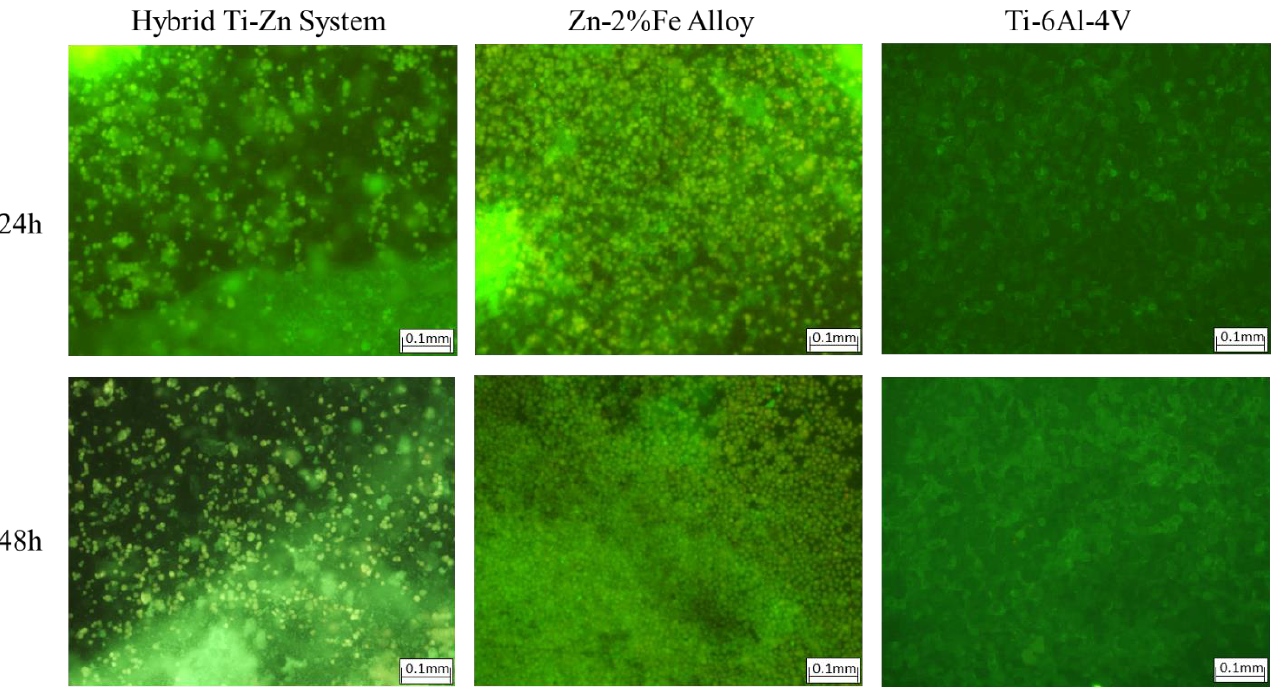
Figure 9. Fluorescence images of live (green) and dead (red) 4T1 cells attached to the corresponding alloys after 24 and 48 h of incubation. Scalebar = 100 μm .